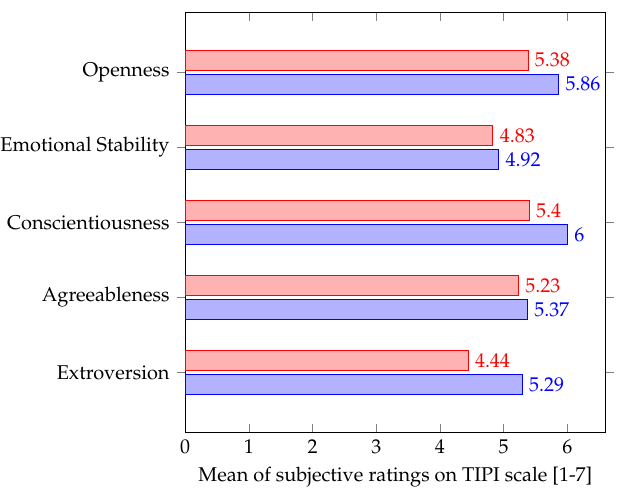
Figure 7. Comparison of TIPI results from user group with 1813 people (this study, blue; norms, red). Z-scores per personality inventory: extroversion, 0.607; agreeableness, 0.115; conscientiousness, 0.455; emotional stability, 0.112; openness, 0.467.